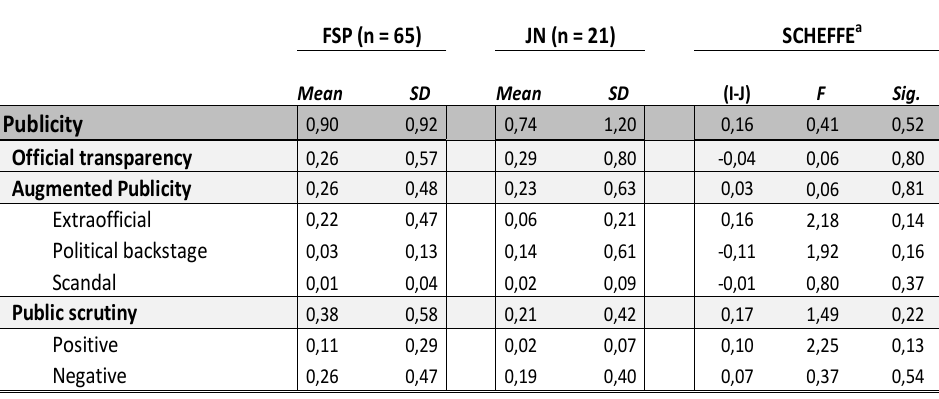
Table 4 . Multiple Comparisons (Scheffé) of Publicity in the COP15 Coverage (FSP and